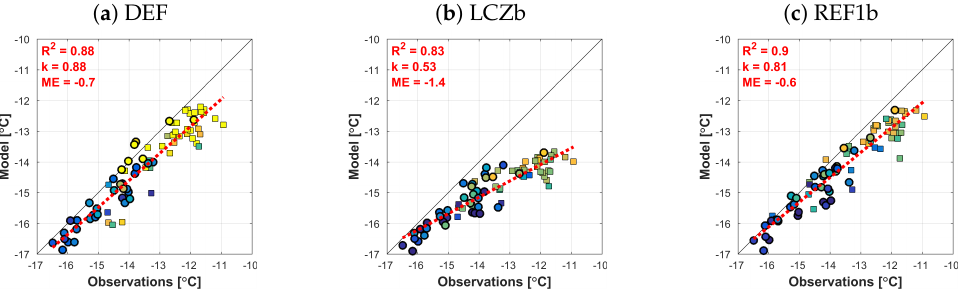
Figure 14. Comparison between observed and modelled daily-mean temperatures, averaged over the selected sub-periods in January 2017 for DEF ( a ), LCZb ( b ) and REF1b ( c ) model simulations. Designations are similar to Figure